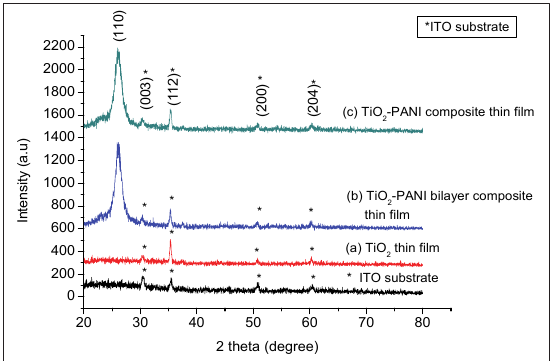
Figure 2. XRD pattern of ( a ) TiO 2 thin film; ( b ) TiO 2 –PANI bilayer composite; and ( c ) TiO 2 –PANI composite thin films. The peaks of ITO substrate are indicated by solid star (*).